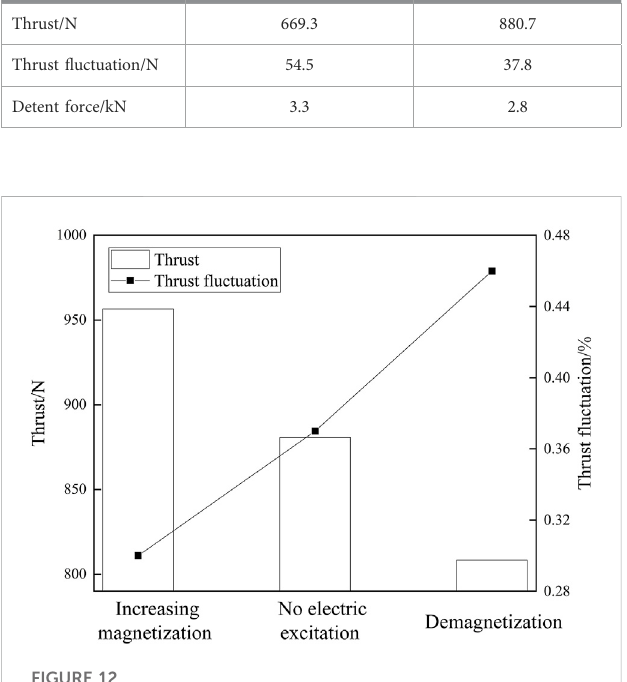
FIGURE 12 Average thrust and thrust fl uctuation of the three states.